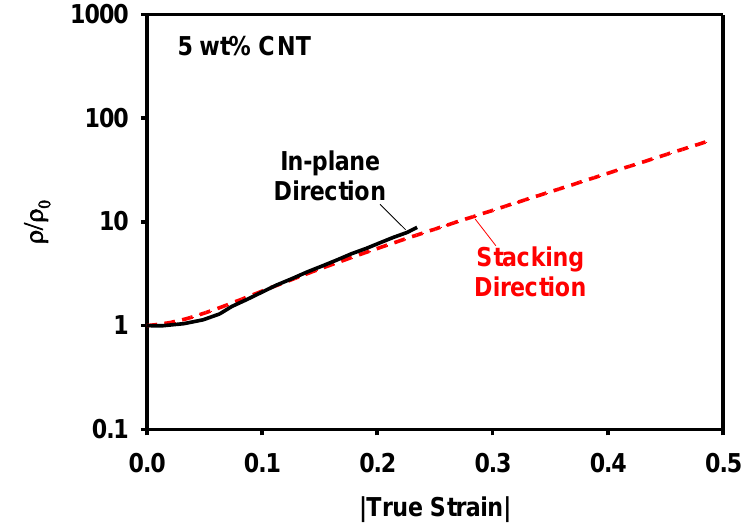
Figure 10. Comparison of the normalized resistivity in the in-plane and the stacking directions.